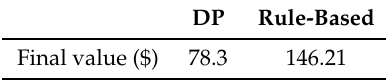
Table 2. The final value in simulation